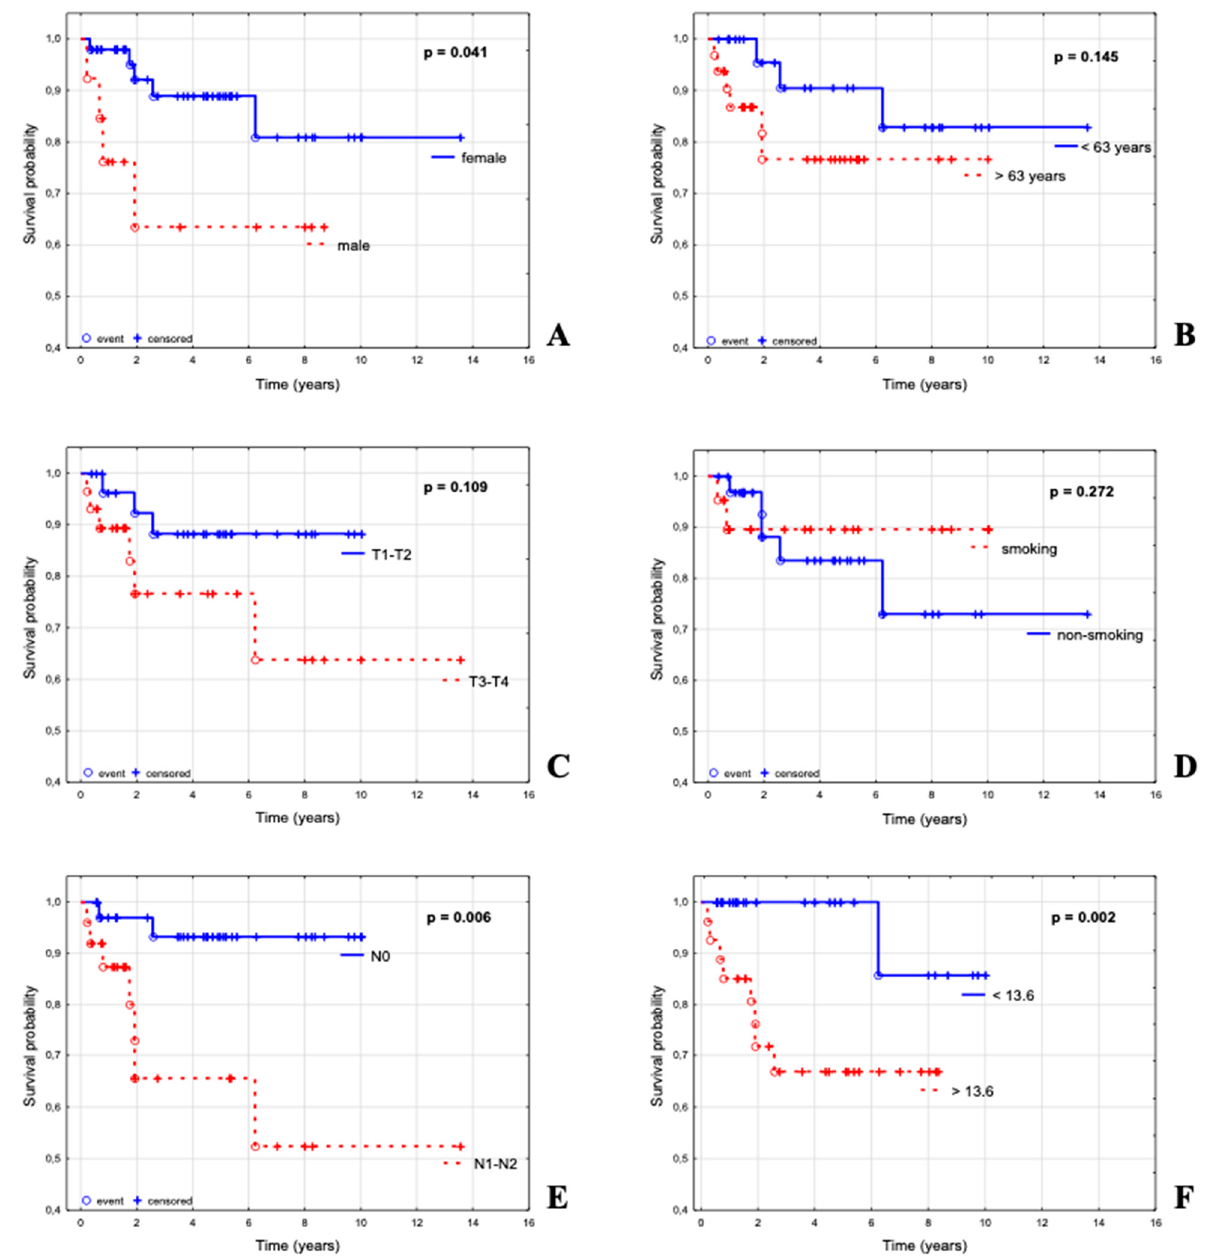
Figure 2. Overall survival (OS) of 62 patients presented using Kaplan–Meier curves stratified by sex ( A ), age ( B ), T stage ( C ) smoking ( D ), N stage ( E ), SUVmax ( F ).